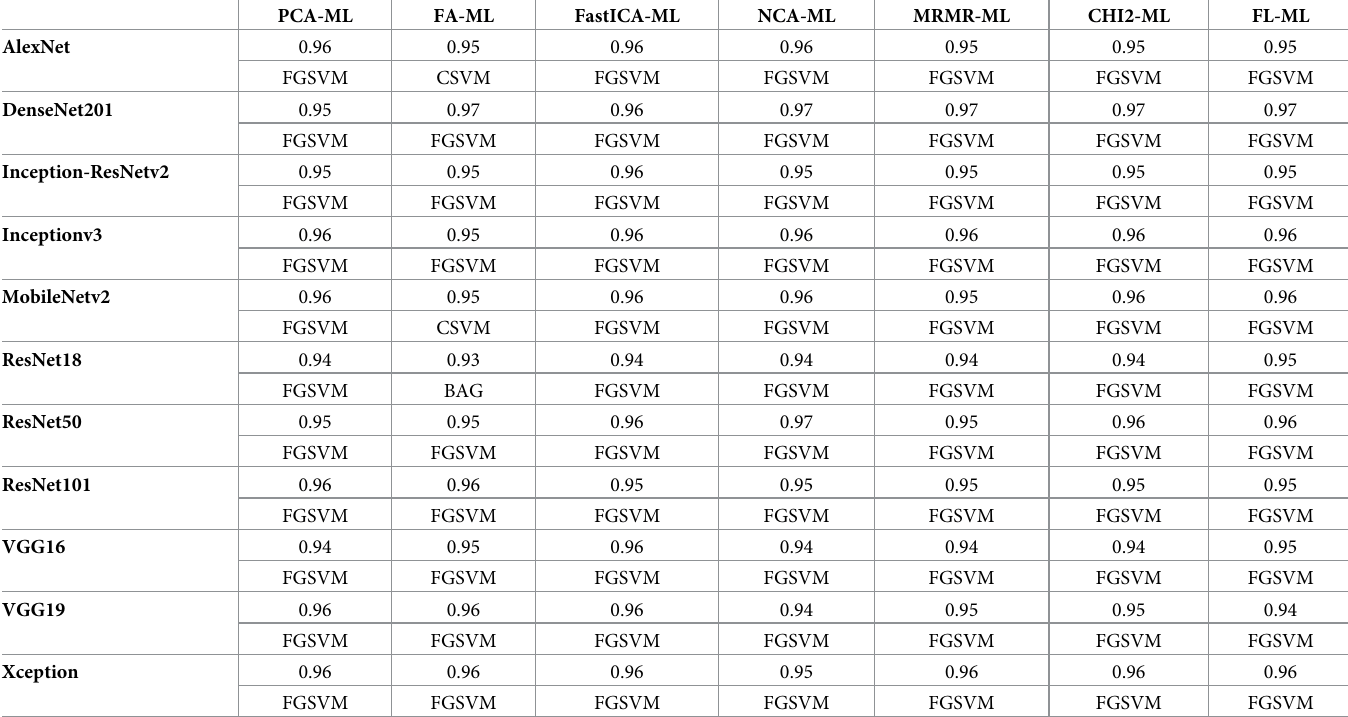
Table 8. The best ML learner for each combination method and its average classification performance (using Precision metric).